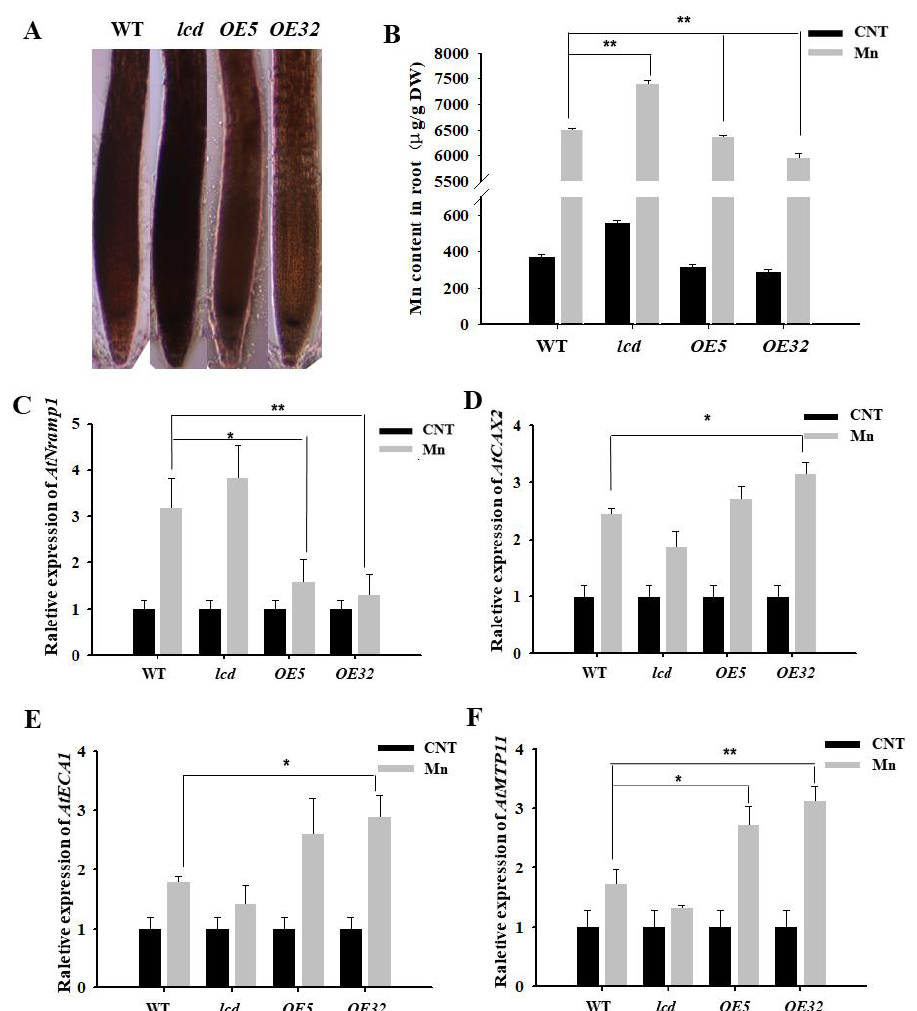
Figure 4. Effects on Mn transporter-related gene expression in roots of lcd and OELCD under Mn stress. Hematoxylin staining ( A ), Mn content ( B ), and the expression of AtNramp1 ( C ), AtCAX2 ( D ), AtECA1 ( E ), and AtMTP11 ( F ) in the roots of wild type, lcd , and two independent overexpression lines under Mn stress. Three independent experimental replications were conducted. Values are the means ± SE of three independent experiments (* p < 0.05; ** p <